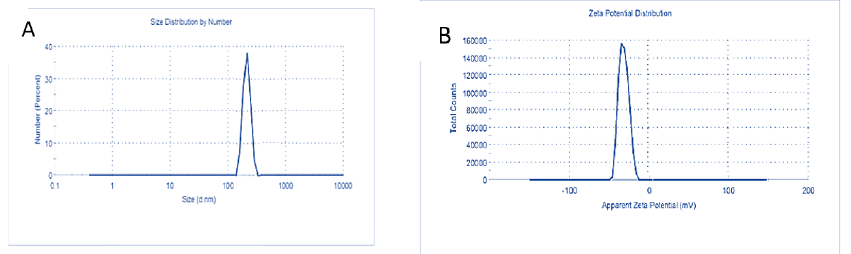
Figure 4. Characterization of BSA-NPs: ( A ). Particle size distribution BSA-NPs; ( B ). BSA-NPs zeta potential.